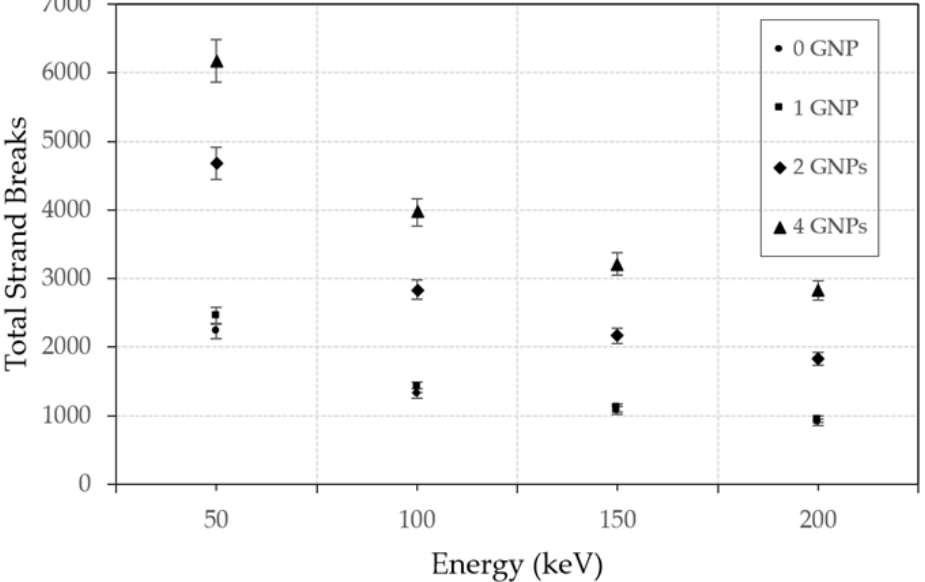
Figure 4. Relationship between the total strand breaks and electron energy (keV) with a dependence on the number of GNPs present. Table 1. Comparison of the number of SSBs to DSBs with increasing number of gold nanoparticles for all energies of 50, 100, 150, and 200 keV combined.